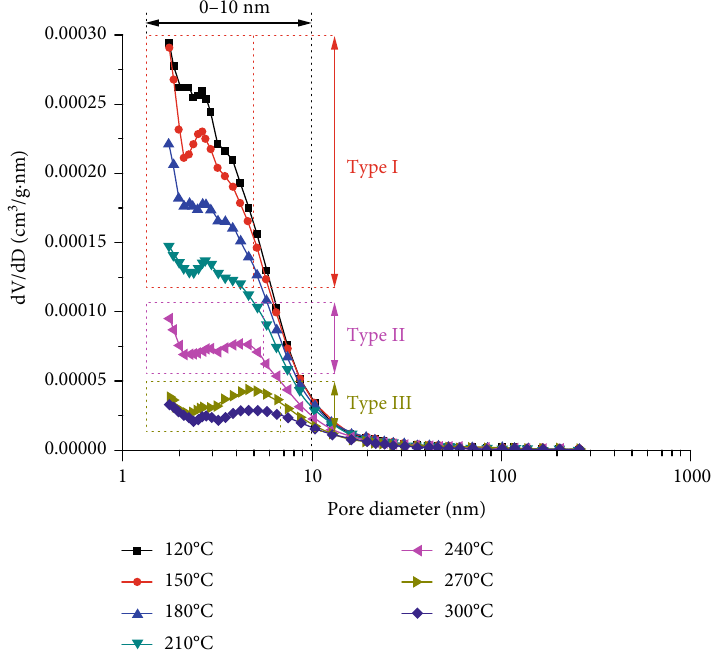
Figure 9: The incremental pore volume of coal under various pretreatment temperatures.